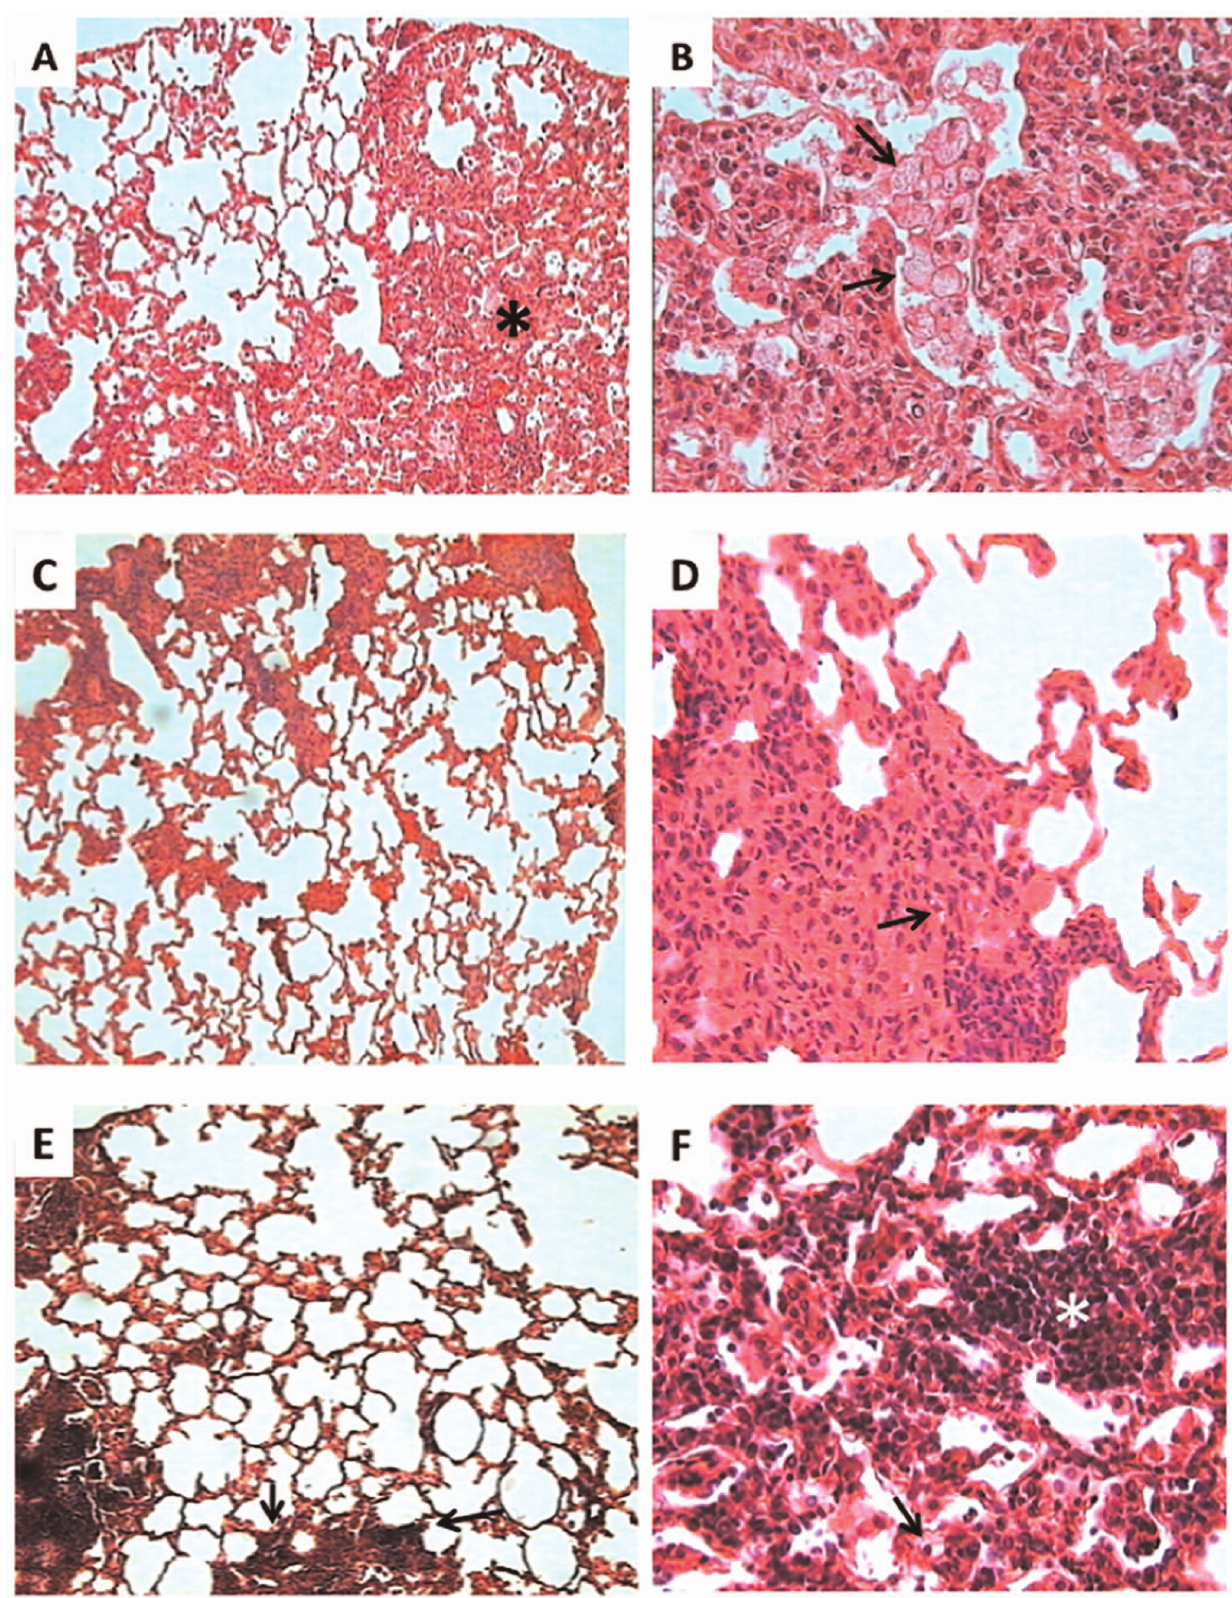
Figure 5. Representative lung histopathology of control non-treated and treated mice during 30 days with IDR-HH2 or IDR-1018. (A) Low power micrograph from a control mouse showing extensive pneumonic areas (asterisk) (H/E, 25x). (B) High power magnification from the